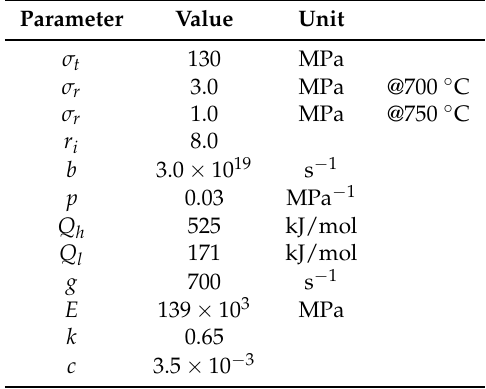
Table 2. Set of model parameters for the Sanicro 25 steel.